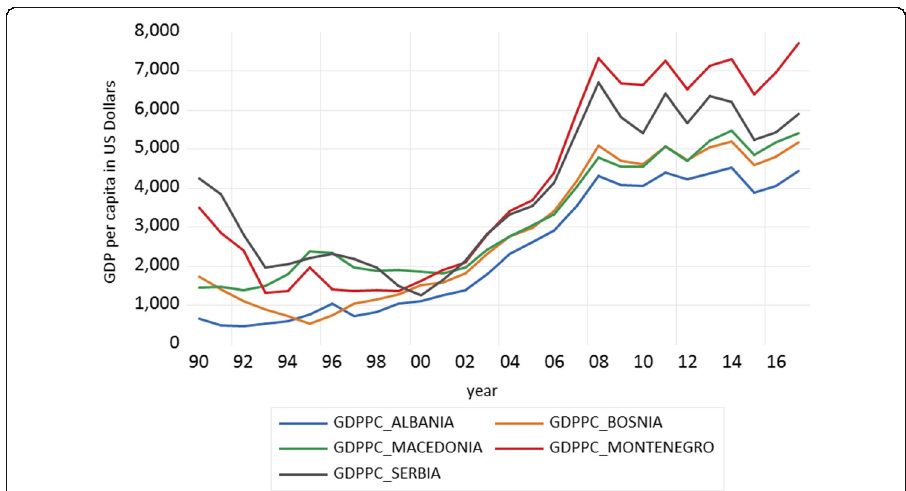
Fig. 1 GDP per capita in US dollars in EU accession candidate countries: 1990 - 201 7 : GDP per capita in US Dollars constant 2010 prices in the EU accession candidate countries 1990 – 2017. Source: UN databases. Author ’ s design based on EViews 11 software using annual time series data from Albania, Macedonia, Serbia, Bosnia and Herzegovina, and Montenegro